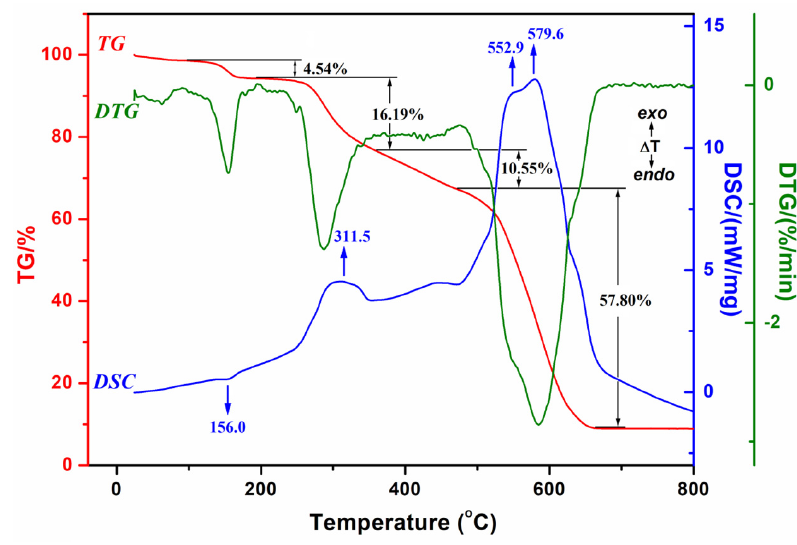
Figure 4. Thermal curves (TG, DTG, and DSC) of complex 1 .